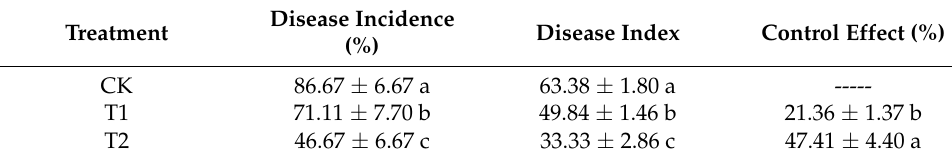
Table 1. Effect of marigold powder on clubroot in Chinese cabbage.